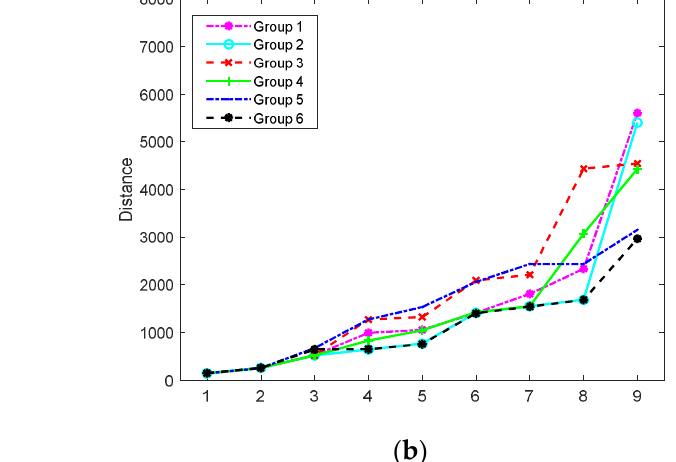
Figure 18. The length of the path required to complete the target search: ( a ) search using the con- ventional RRT algorithm and ( b ) search using the improved RRT algorithm.